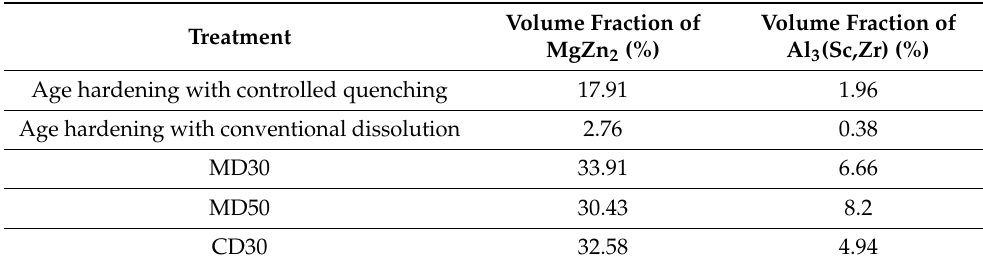
Table 6. Comparison of volume fraction of Al 3 (Sc,Zr) and MgZn 2 precipitates in the alloys containing 0.1% Sc in specimens under different treatment conditions, using MIP software analysis.